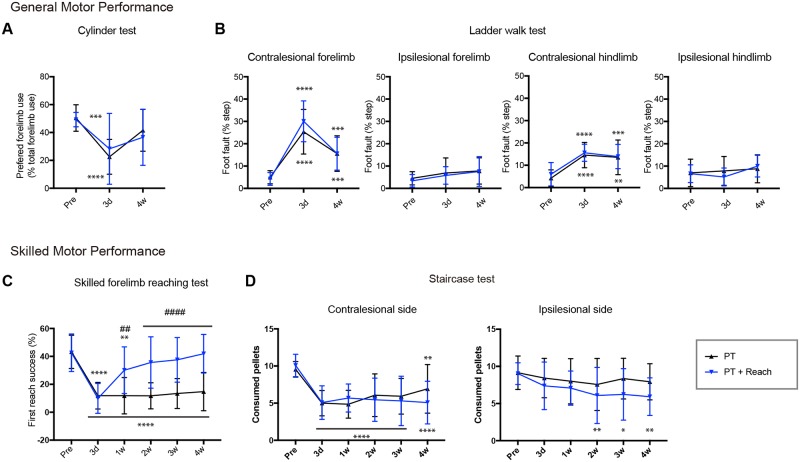
The effect of skilled forelimb training on functional recovery following stroke.(A) Results of the cylinder test. Rats showed a significant decrease in use of the preferred forelimb following stroke. Preferred forelimb use recovered in both groups. (B) Results of the ladder walk test. Stroke increased foot fault in the contralesional forelimb and hindlimb. Although the amount of foot fault decreased slightly in the contralesional forelimb 4 weeks following stroke, sustained disabilities were observed both in the contralesional forelimb and hindlimb. (C) Results of the skilled forelimb reaching test. Stroke caused severe disability in the skilled forelimb reaching task. While rats without rehabilitative training showed almost no improvement in motor performance, rats with rehabilitative training achieved nearly full recovery. (D) Results of the staircase test. Stroke caused impaired motor performance in the contralesional side. The impairment persisted until 4 weeks following stroke in both the untrained and trained rats. Unexpectedly, the trained rats showed a significant decline in motor performance in the ipsilesional (less affected) side. Repeated measures two-way ANOVA, followed by post-hoc test: Tukey’s multiple comparison test for the comparisons between the different time points. *p<0.05, **p<0.01, ***p<0.001, ****p<0.0001 vs. pre-stroke in the same group, Sidak’s multiple comparison test for the comparison between groups at each time point. ##p<0.01, ####p<0.0001 PT vs. PT + Rehab.